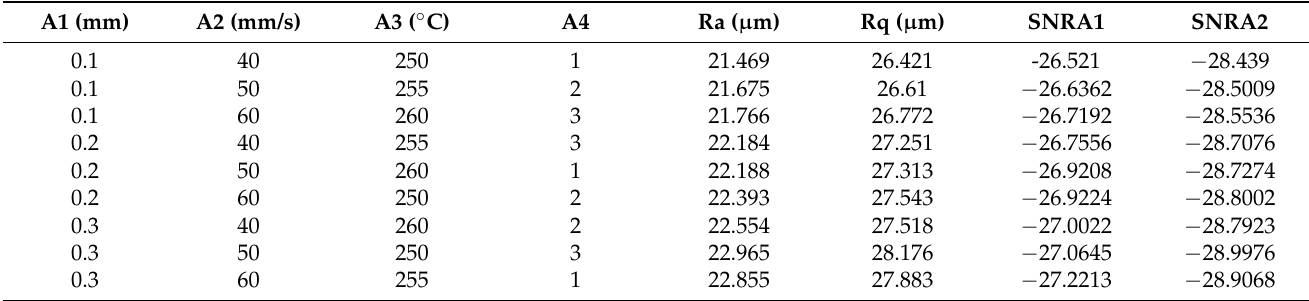
Table 6. Experimental design, results, and their computed S/N ratios for PA-6